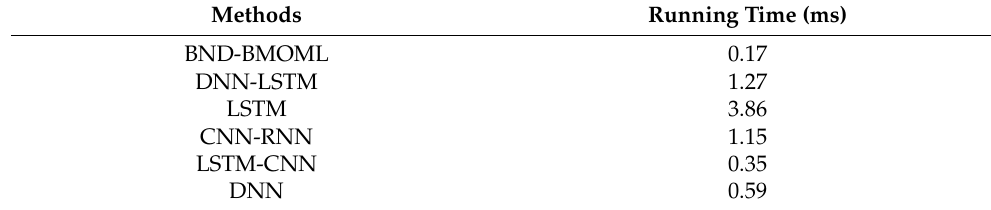
Table 6. Running time analysis for BND-BMOML approach and recent algorithms.